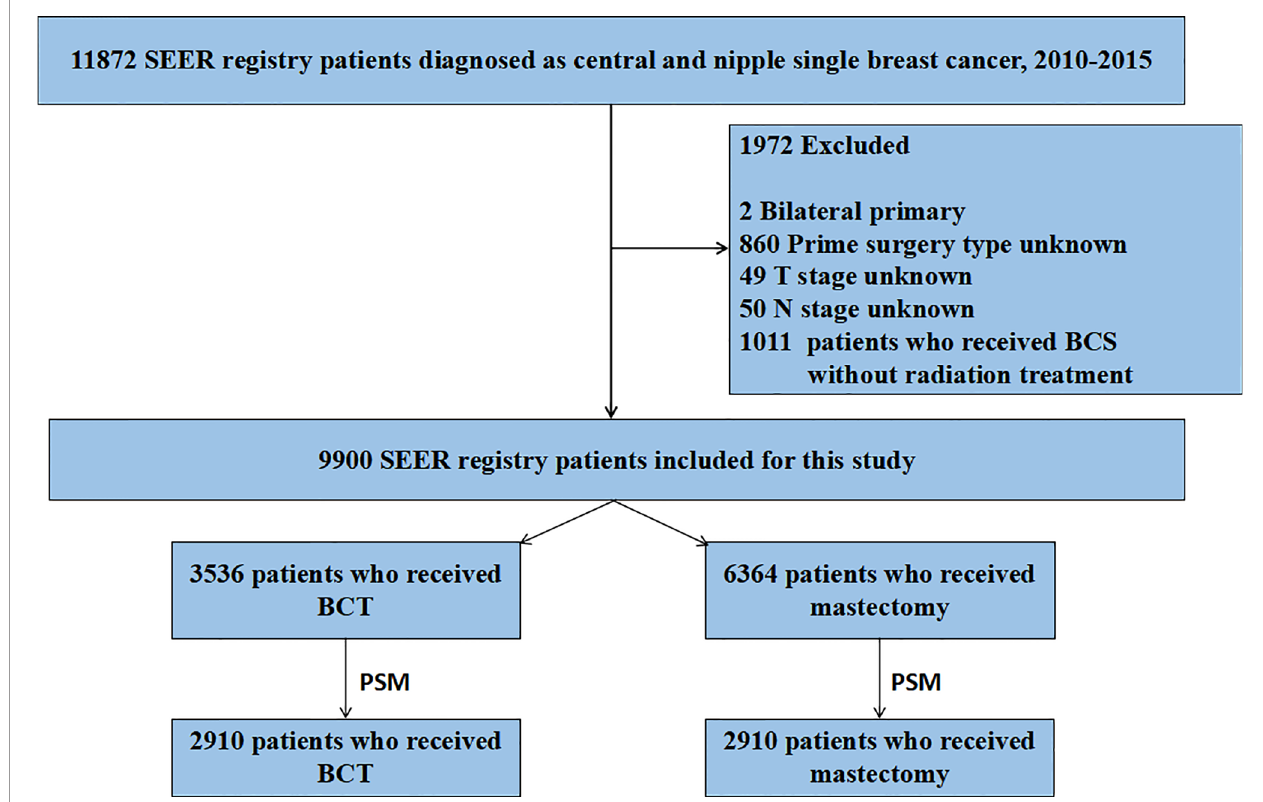
FIGURE 1 | Flow chart for screening patients. SEER, Surveillance Epidemiology, and End Results; PSM, propensity score matching. BCT, breast-conserving